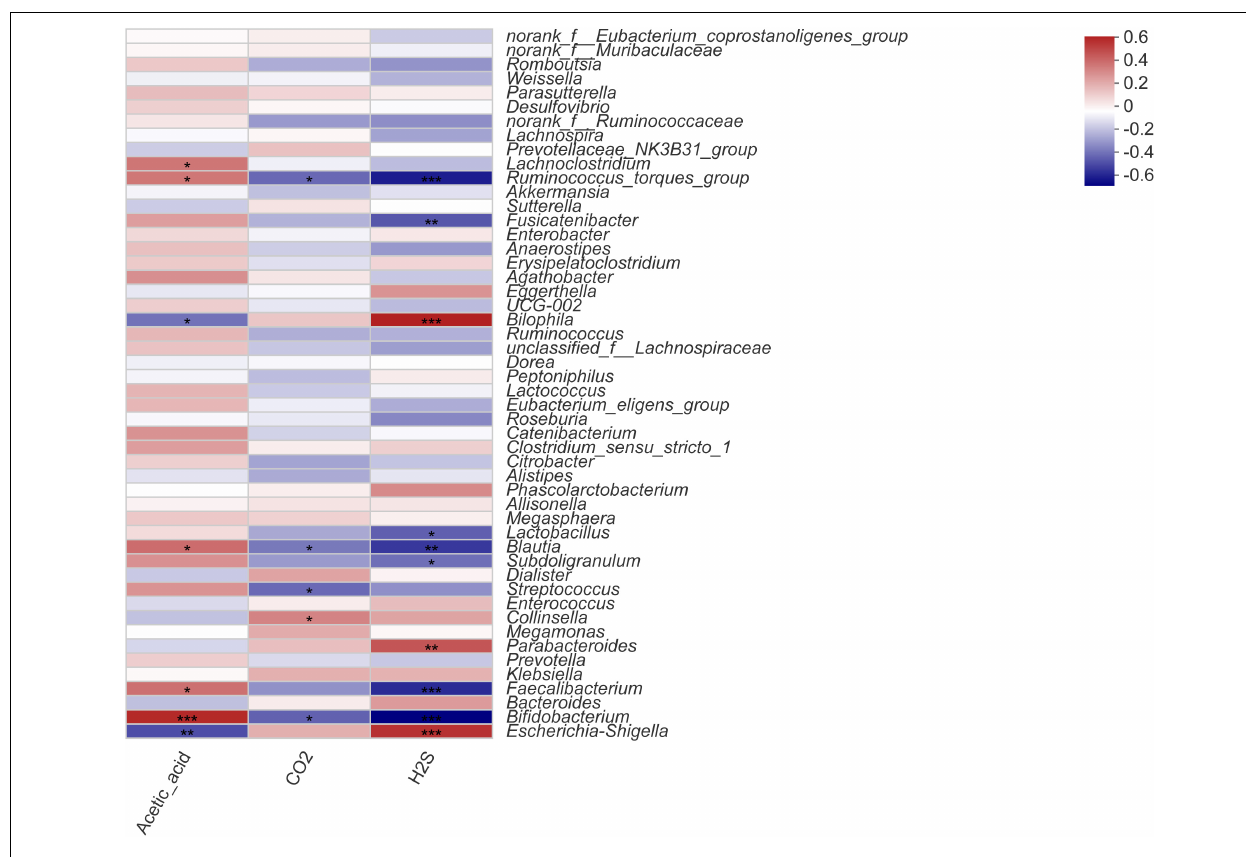
FIGURE 5 | Spearman correlation heatmap for microorganisms at the genus level with acetic acid, CO 2 , and H 2 S content. Statistical significance was calculated by one-way ANOVA with LSD test, * P < 0.05, ** P < 0.01, and *** P < 0.001 were considered with significant